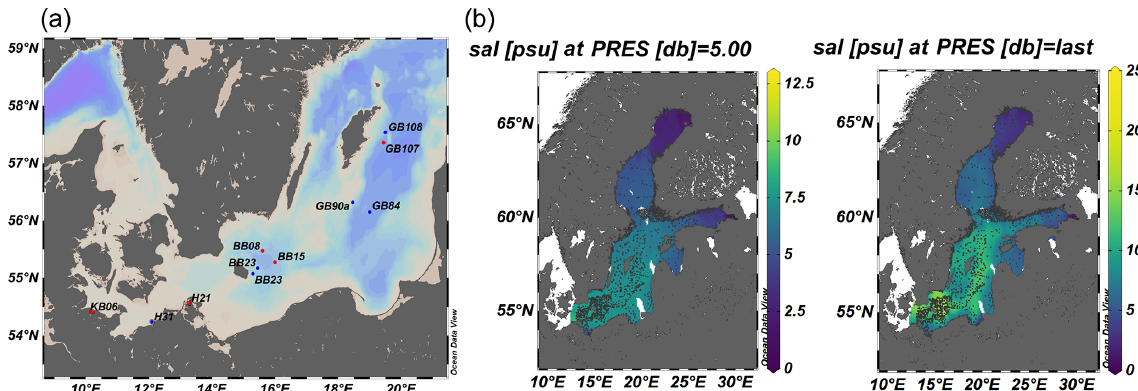
Figure 1. Overview of cruise track and stations from this study. (a) Distribution of O 2 , salinity (sal) in surface water (5m), and the deepest sample at the station (last) in the Baltic Sea. Stations from which N 2 fixation were obtained are colored red. Data for (b) were obtained through ICES oceanography spanning from 1 August to 30 October 2019 (ICES Copenhagen,